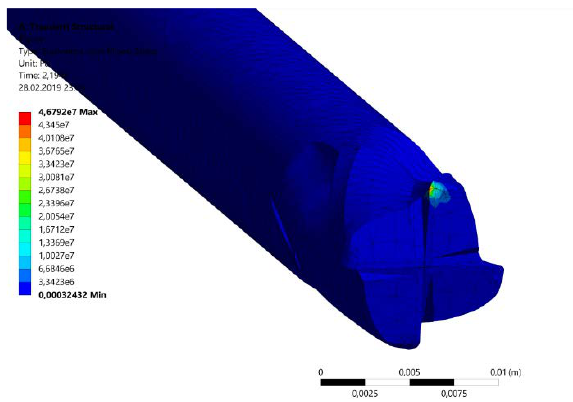
Fig. 4. Solution of finite-element deformation modeling